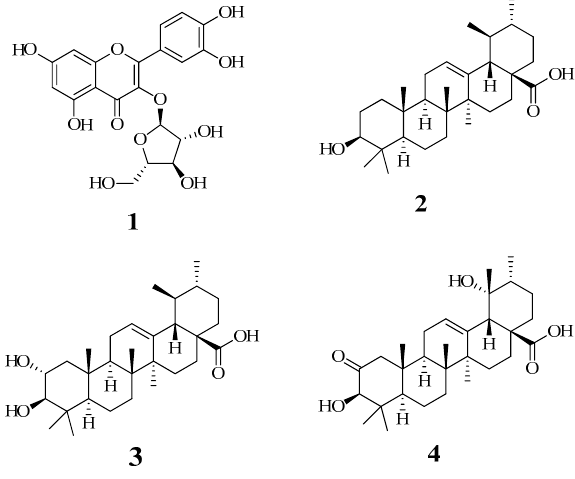
Figure 1. The structures of compounds 1 – 4 isolated from the fruits of Malus domestica .